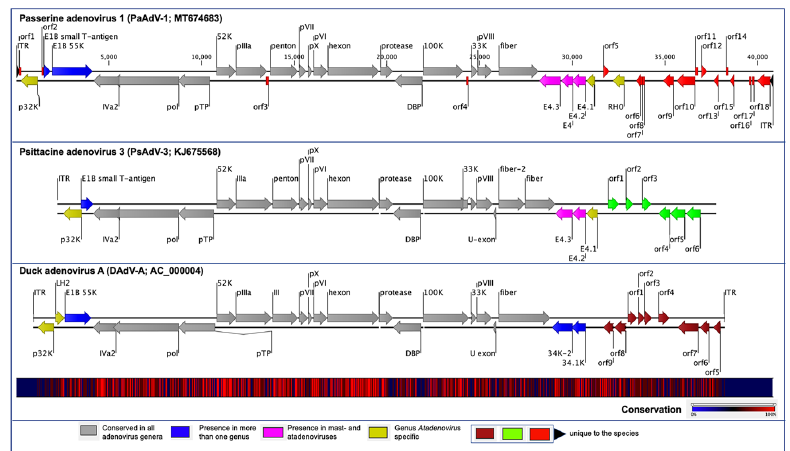
Figure 1. Schematic illustration of the avian atadenoviruses. Schematic map of the passerine adenovirus 1 (PaAdV-1, GenBank accession no. MT674683), in comparison with duck adenovirus A (DAdV-A, GenBank accession no. AC_000004) and psittacine adenovirus 3 (PsAdV-3, GenBank accession no. KJ675568), using CLC Genomic Workbench (version 9.5.4, CLC bio, a QIAGEN Company, Prismet, Aarhus C, Denmark). The arrows symbolize adenovirus genes and open reading frames (ORFs) predicted to code for proteins, indicating their direction of transcription. Each gene or ORF is colour coded, as indicated by the colour key in the legend. The bottom graph represents the sequence conservation between the aligned PaAdV-1, DAdV-A, and PsAdV-3 sequences at a given coordinate at each position in the alignment. The gradient of the colour reflects the conservation of that particular position is in the alignment. Red presents 100% conservation across all three viruses, black 50% conserved regions, and blue less than 50% conserved